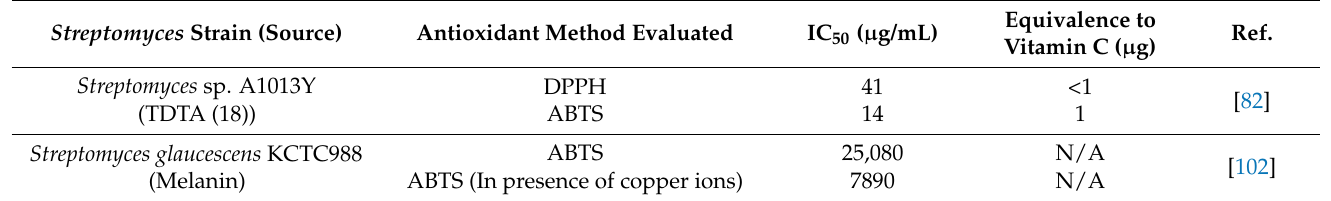
Table 7. Results (IC 50 and equivalence to vitamin C) of the Streptomyces strains with antioxidant activity reported.